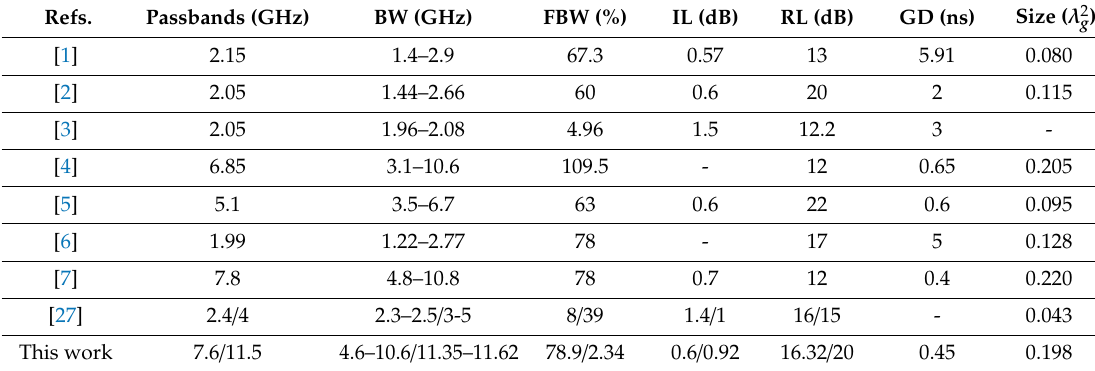
Table 1. Specifications of cited papers and proposed